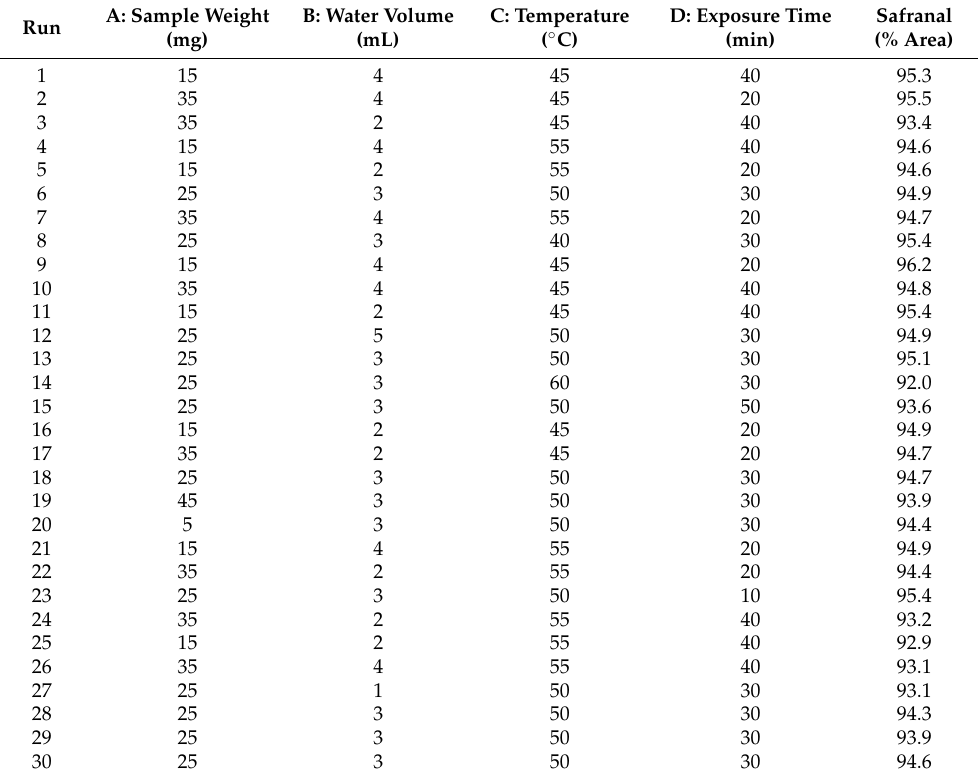
Table 1. Central composite design for the four independent experimental factors (A, B, C, and D) along with the experimental values of the response